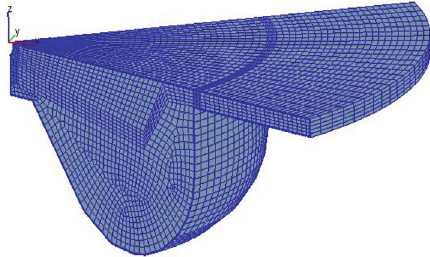
Figure 1: 3D grid model of the combustor of the 4135ACa